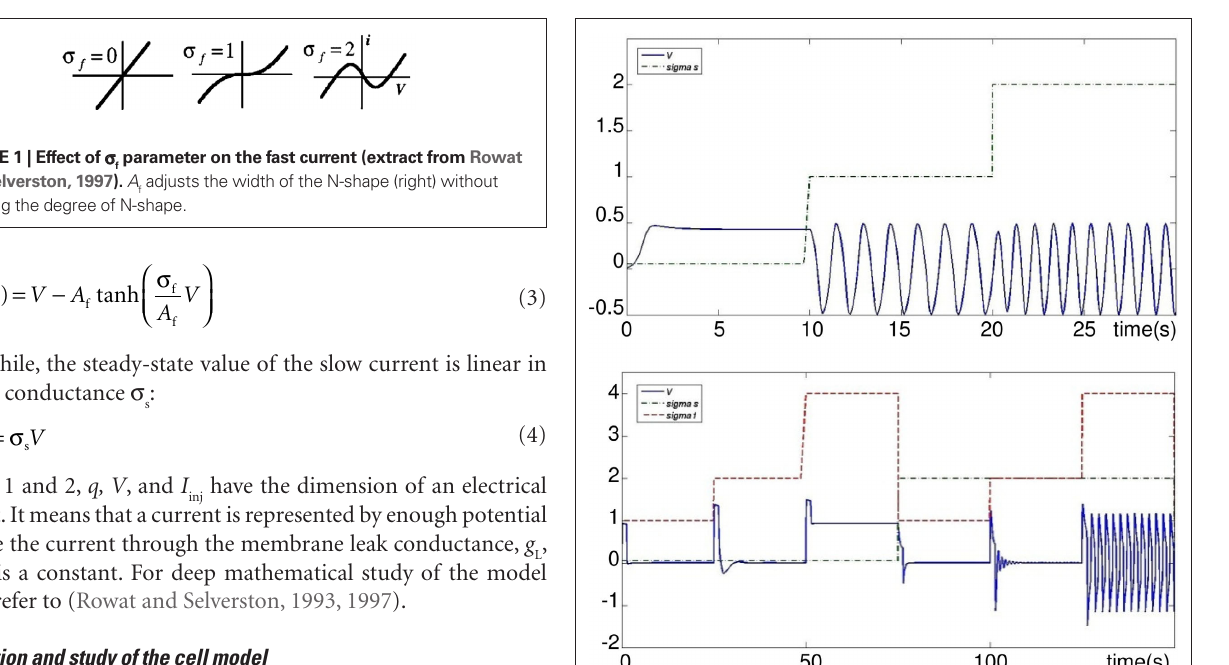
∈ [0.05,1,2]. Bottom: σ s occurs simultaneously to each change of σ inj